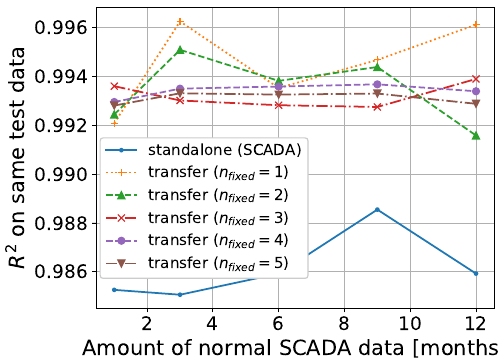
Figure 21. Standard deviation of R 2 value for SDAE for different amounts of training data and knowledge transfers.